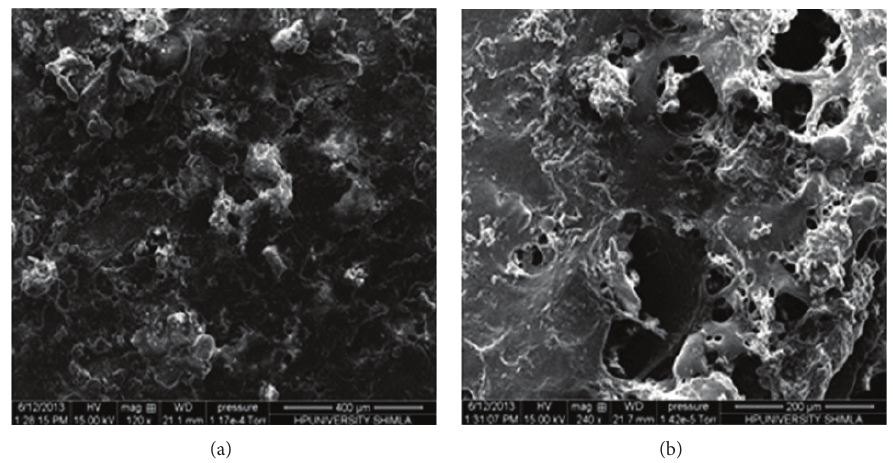
Figure 2: SEM photomicrographs of (a) outer surface and (b) inner surface of AMC.